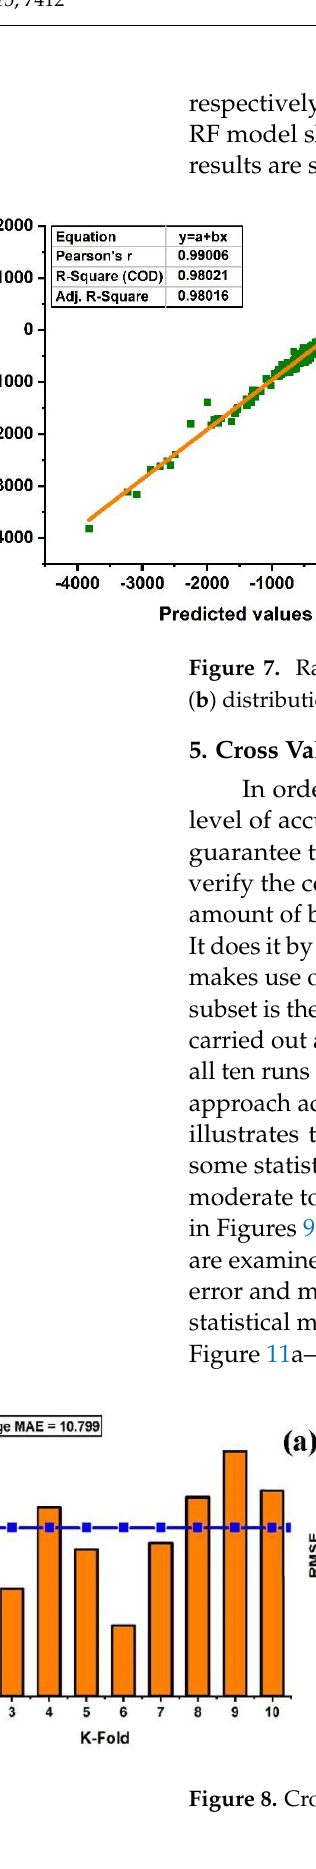
Figure 9. Cross validation; ( a ) SVR-adaboost with MAE; ( b ) SVR-adaboost with RMSE; ( c ) SVR- adaboost with R 2 .